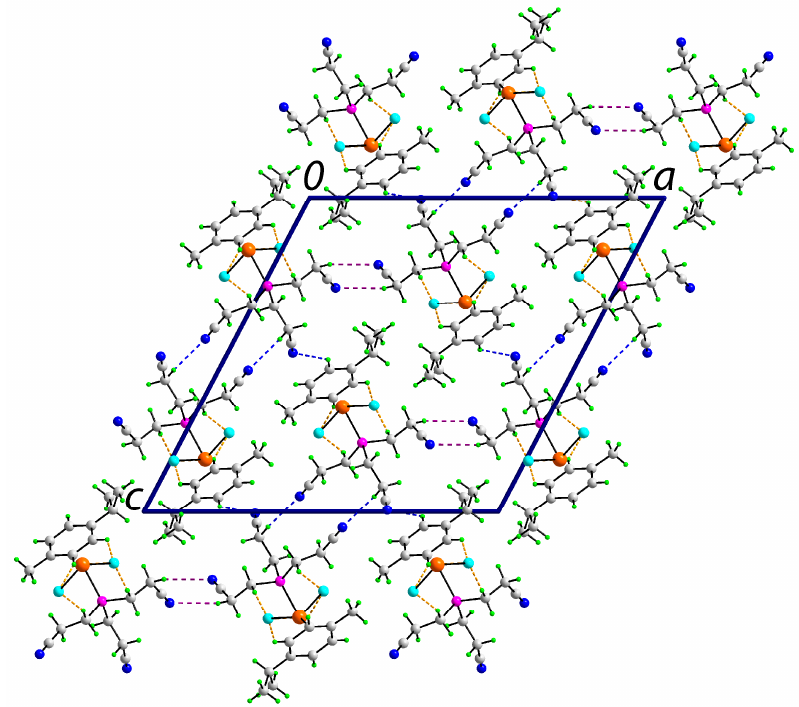
Table 1. Geometric parameters (Å, °) characterising the non ‐ covalent (A–H ⋯ B) interactions present in the crystal of 1 .